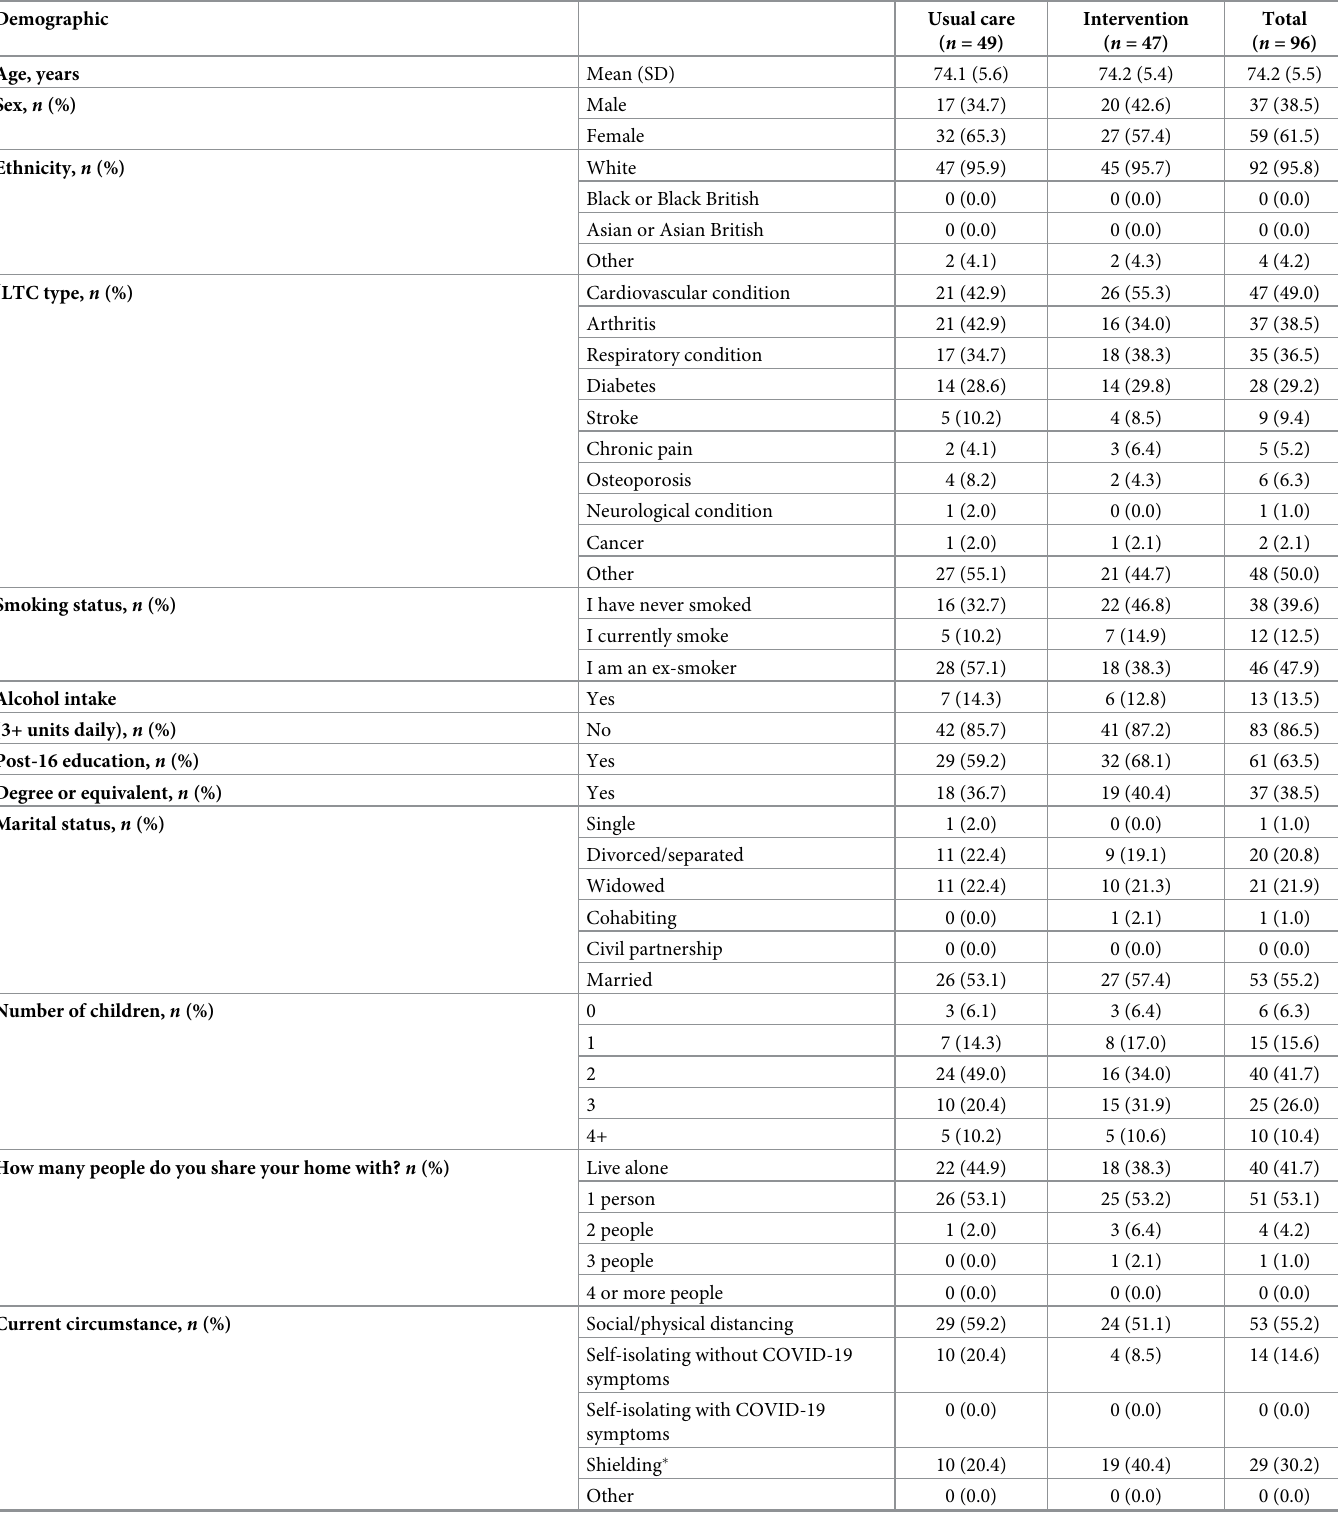
Table 1. Baseline demographics of participants as